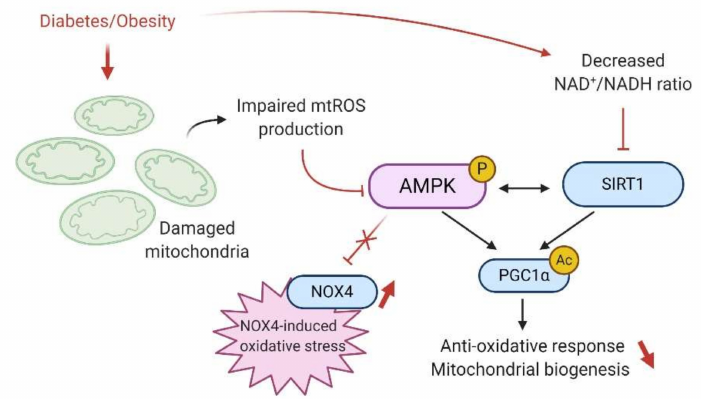
Figure 4. Schematic representation of the proposed mechanism by which diabetes / obesity leads to a decreased antioxidative response mediated by AMPK and enhanced oxidative stress in the renal cell. Regulation of mitochondrial production of reactive oxygen species (ROS) is required for the proper adaptation of the renal cell to metabolic stress. Diabetes and obesity impair renal mitochondrial ROS, which is associated with decreased AMPK. AMPK inhibition and decreased SIRT1 activity lead to a maladaptive antioxidative response through PGC1- α activity suppression, notably decreasing mitochondrial biogenesis. Decreased AMPK also results in increased NOX4-dependent ROS production, further increasing oxidative stress in renal cells. The arrow indicates whether the regulation is activating (black) or inhibitory